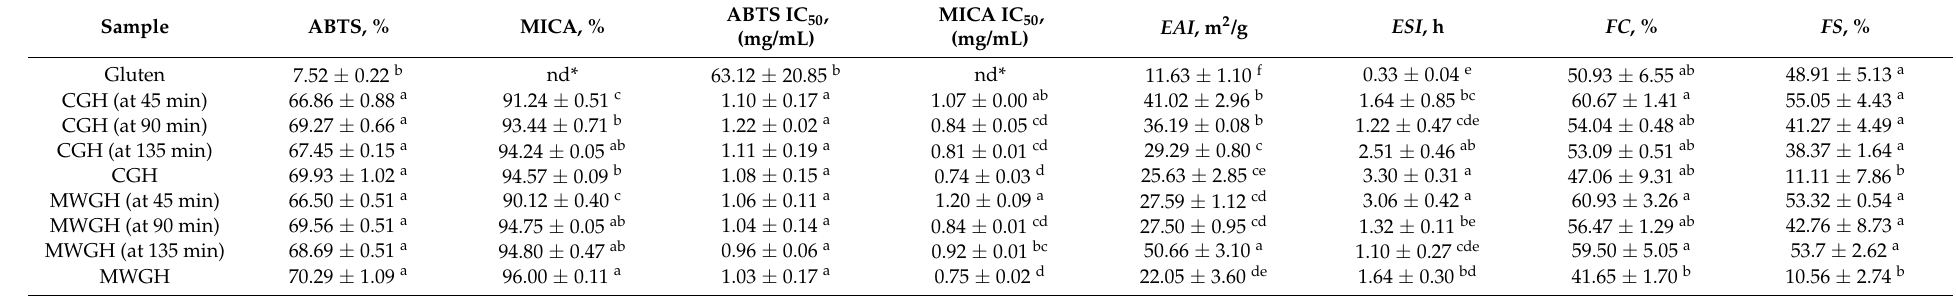
Table 2. ABTS (%), MICA (%), ABTS IC 50 (mg protein /mL), MICA IC 50 (mg protein /mL), EAI (m 2 /g) and ESI (h), FC (%) and FS (%) values for untreated gluten, control gluten hydrolysate (CGH) and microwave pretreated gluten hydrolysate